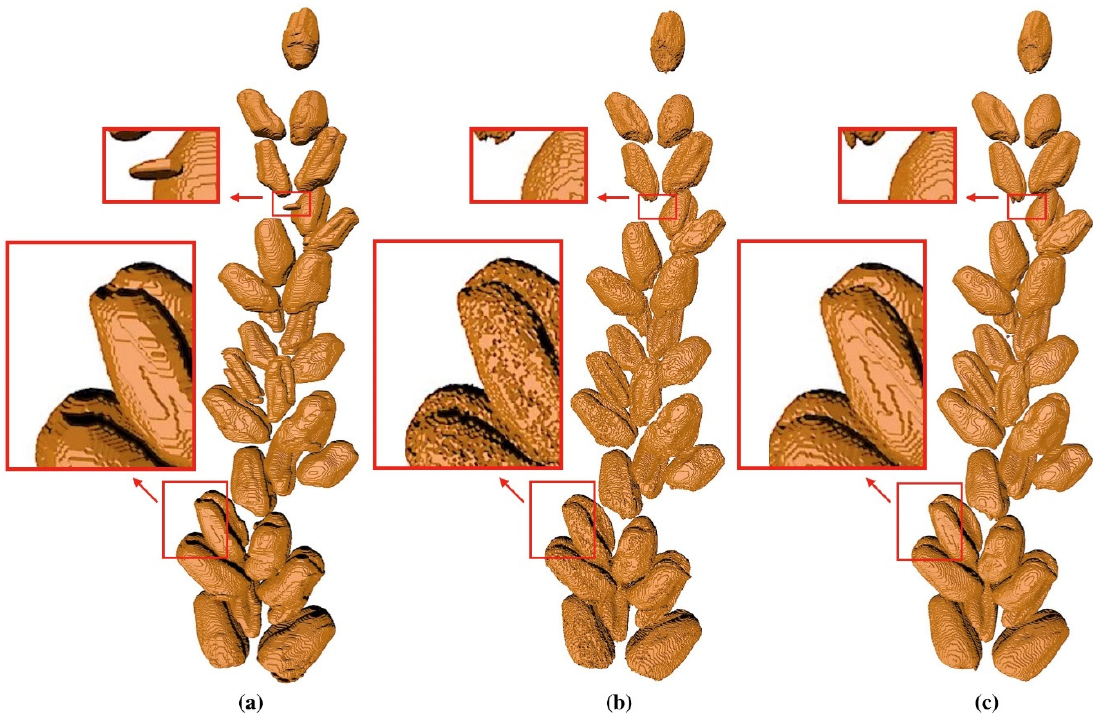
Figure 16. The detection results of the top part of wheat spike with treatment No. 1178. ( a ) Grains detected by Hughes’ method; ( b ) Grains detected by our method; ( c ) Manually labeled grains. The difference between our and Hughes results is marked with a red box.